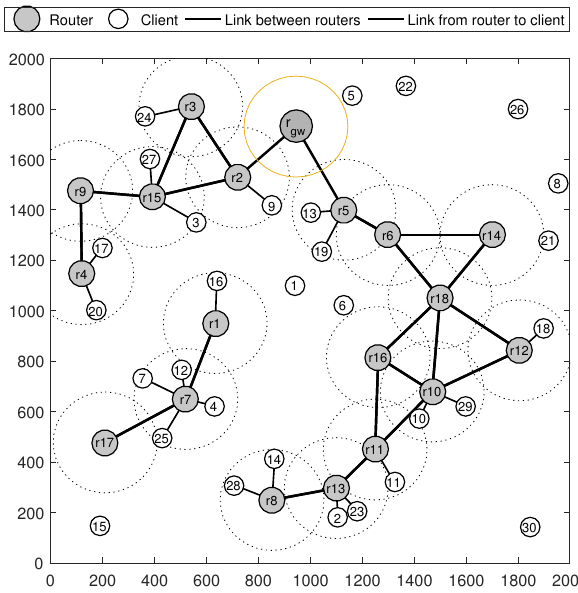
Figure 2. An example of the topology of the